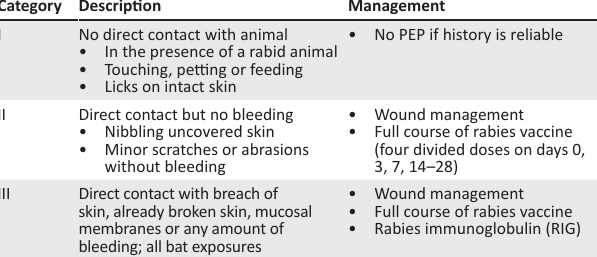
TABLE 1: Categories of exposure and recommended post-exposure prophylaxis. Category